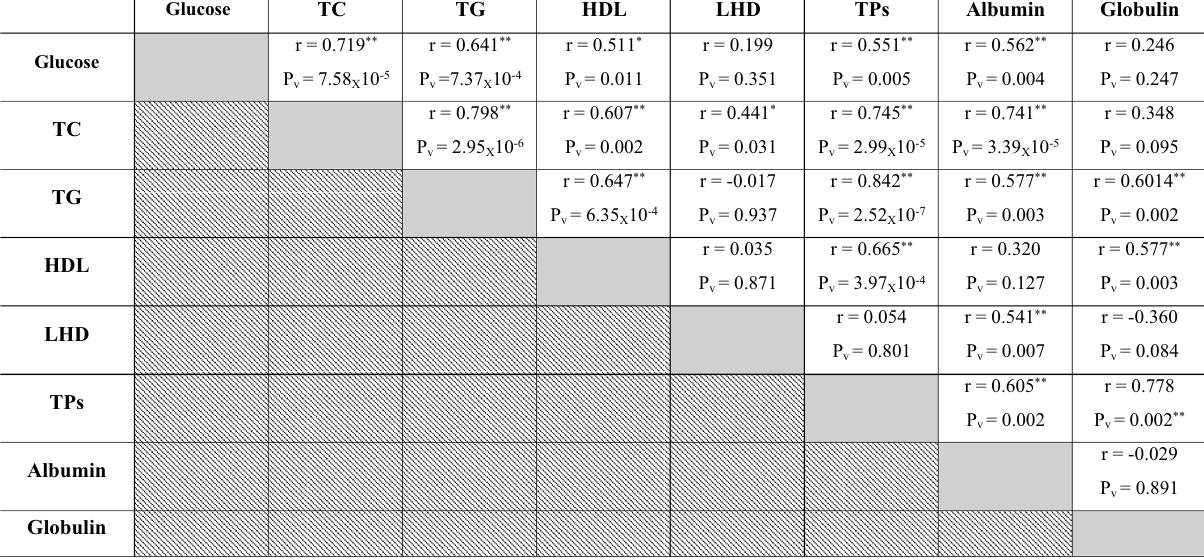
Table 3. Pearson correlation coefficient between blood lipid profiles in investigated Dabb lizards. TC Total cholesterol, TG Triglyceride, HDL High-density lipoprotein, LHD Low-density lipoprotein, TPs Total proteins,